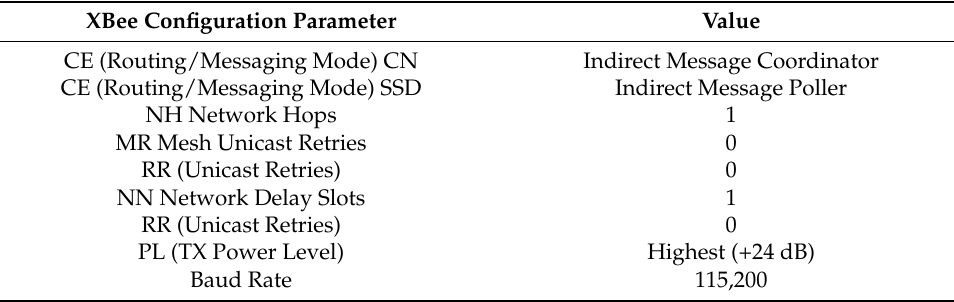
Table 1. Most relevant XBee configuration